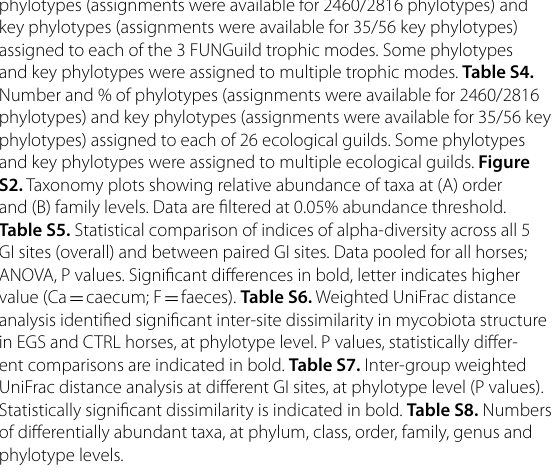
Table S5. Statistical comparison of indices of alpha-diversity across all 5 GI sites (overall) and between paired GI sites. Data pooled for all horses; ANOVA, P values. Significant differences in bold, letter indicates higher value (Ca caecum; F faeces). Table S6. Weighted UniFrac distance = = analysis identified significant inter-site dissimilarity in mycobiota structure in EGS and CTRL horses, at phylotype level. P values, statistically differ- ent comparisons are indicated in bold. Table S7. Inter-group weighted UniFrac distance analysis at different GI sites, at phylotype level (P values). Statistically significant dissimilarity is indicated in bold. Table S8. Numbers of differentially abundant taxa, at phylum, class, order, family, genus and phylotype levels. Additional file 2 . Differentially abundant (increased and decreased) taxa. Separate sheets show differentially abundant taxa at Phylum, Class, Order, Family, Genus, phylotype (increased and decreased abundance) and OTU (increased and decreased abundance) levels. Separate columns show statistical data for comparisons overall (OV; pooled data for all GI sites) and at paired GI sites (ST; stomach, IL; ileum, CA; caecum, CO; colon, FA; faeces), for EGS vs CTRL, and for faeces for EGS vs CoG and for CoG vs CTRL groups. Separate columns show adjusted p value (padj) and log 2 fold change, and for phylotype data, VIP scores for statistically significant paired